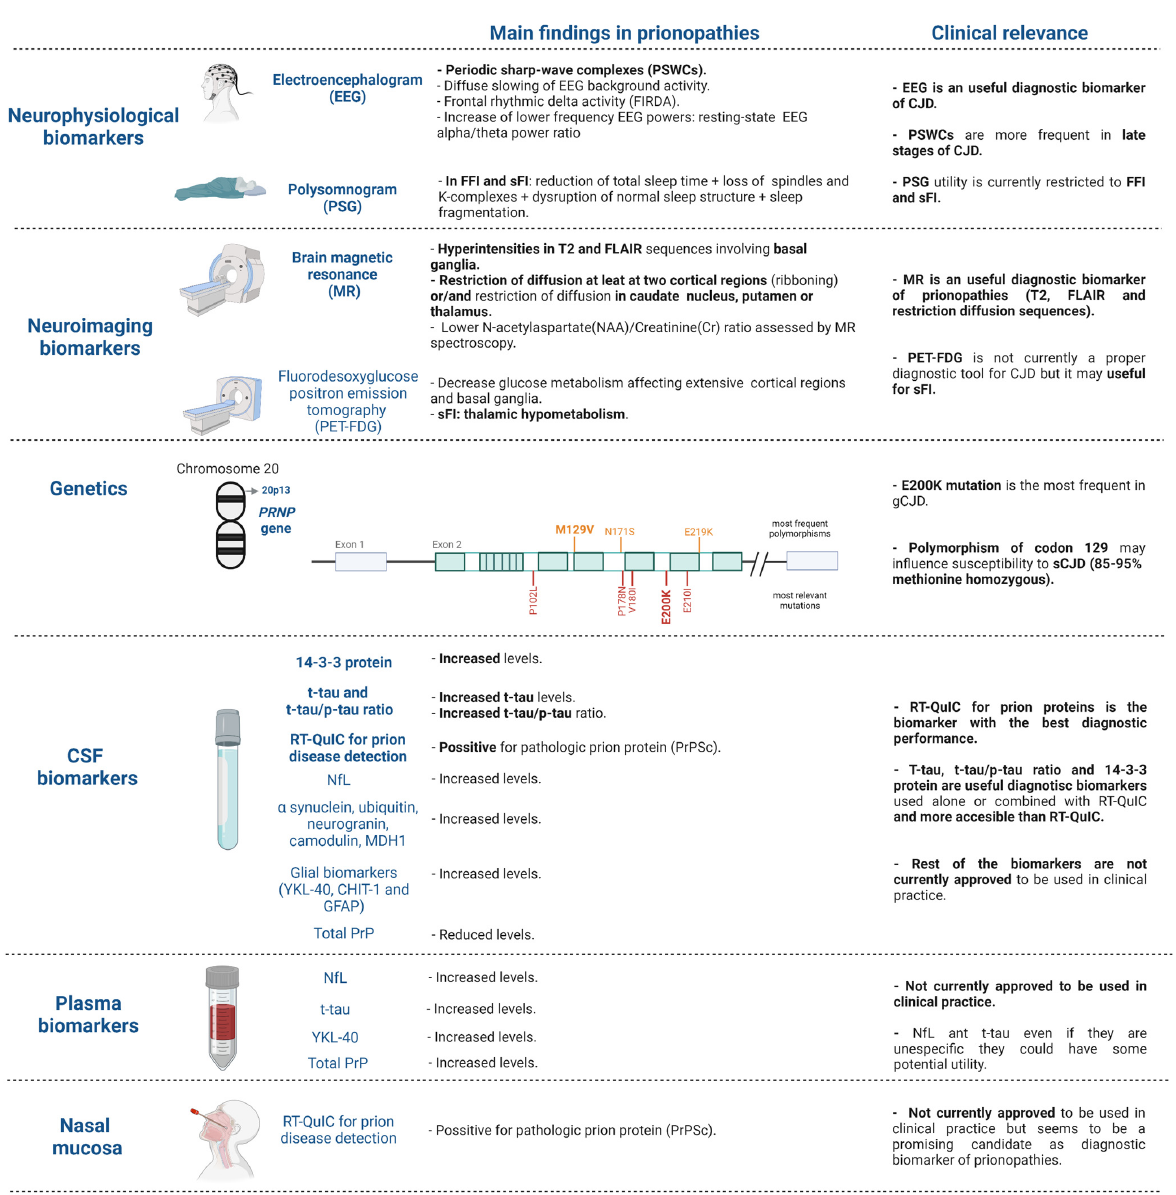
Figure 2. Diagnostic biomarkers for prion diseases in use in clinical practice and summary of the most promising biomarkers under investigation. Figure created with biorender.com. CJD: Creutz ‐ feldt–Jakob diseases, sCJD: sporadic Creutzfeldt–Jakob disease; gCJD: genetic Creutzfeldt–Jakob disease, FFI: fatal familial insomnia, sFI: sporadic fatal